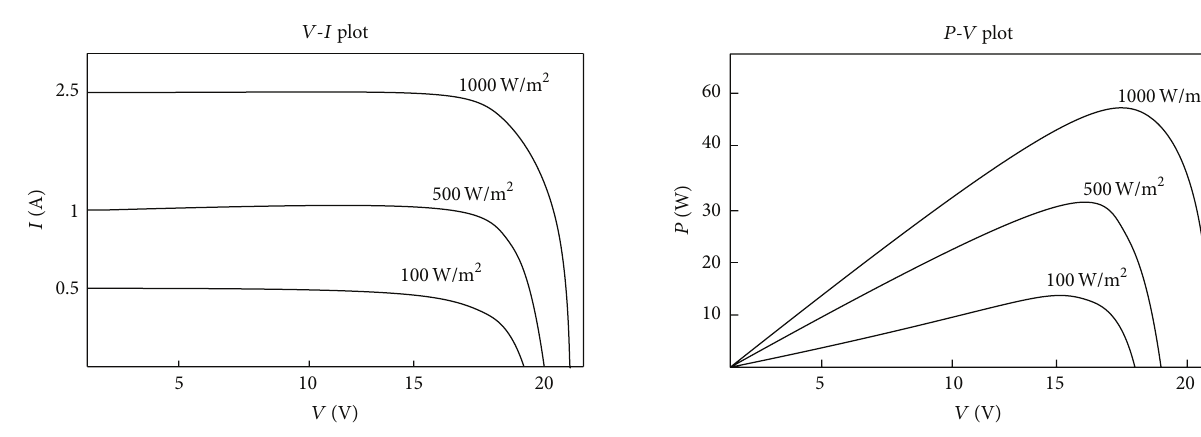
Figure 4: Characteristics curve for SOLKAR 36W module. 𝑉 - 𝐼 curves of SOLKAR 36W at different radiations.